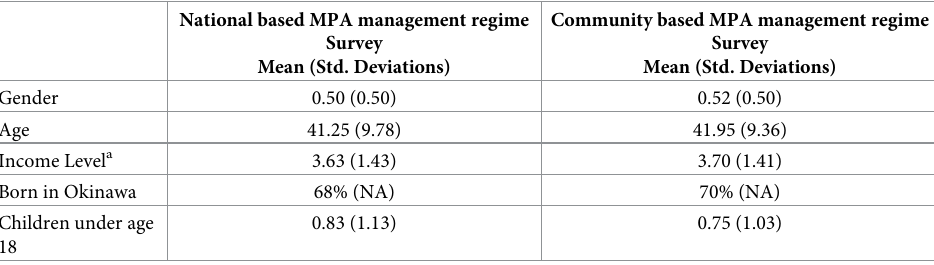
Table 2. Socio-economic characteristics of survey